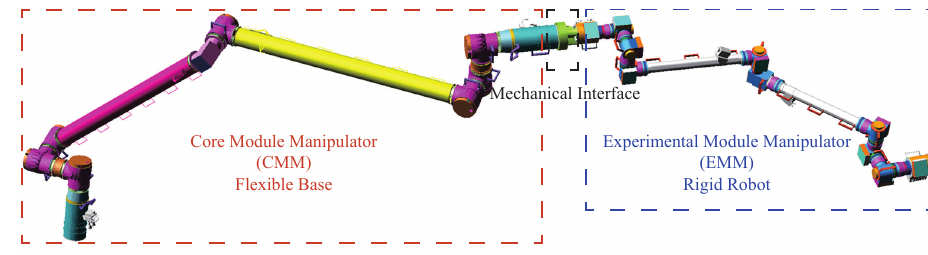
Figure 1. The CMM and EMM series